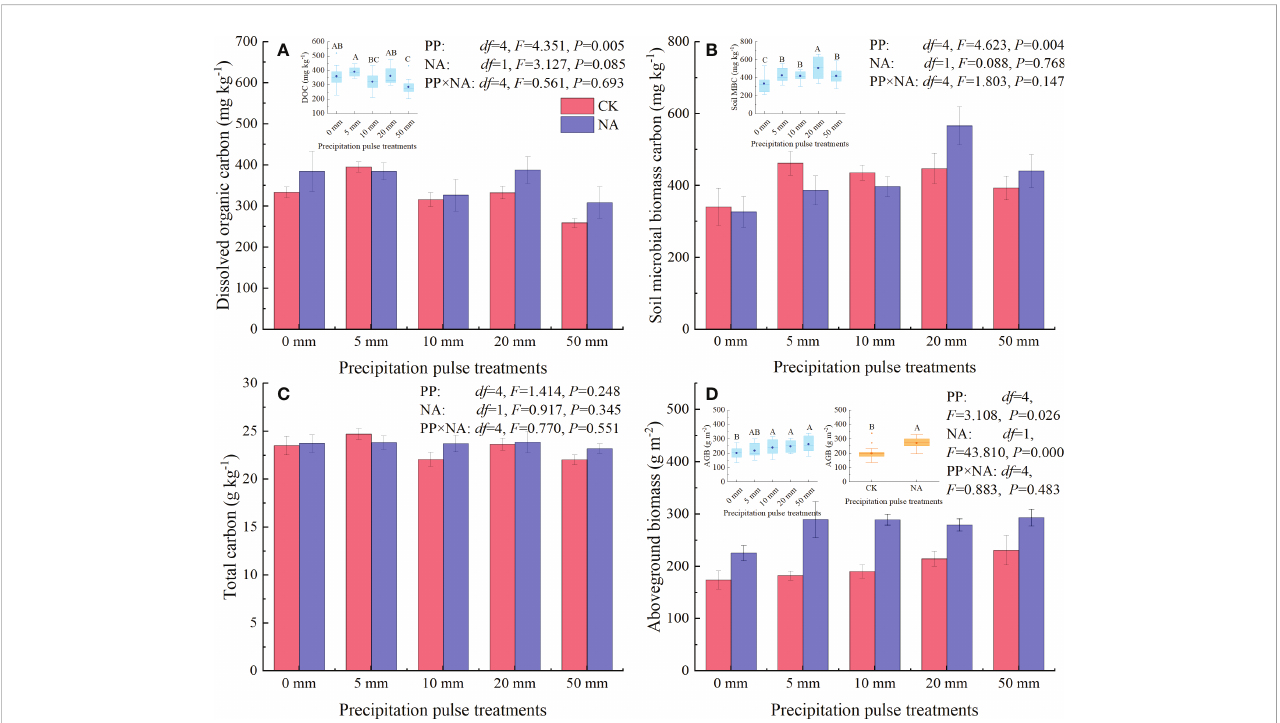
FIGURE 3 Responses of dissolved organic carbon (DOC, A ), soil microbial biomass carbon (MBC, B ), total carbon (TC, C ), and aboveground biomass (AGB, D ) to precipitation pulses and N addition treatments. The inserted graphs (light blue column) in panels A, B, D show the differences in DOC, MBC, and AGB among the precipitation pulses. The inserted graphs (orange column) in panel D show the differences in AGB between the control and N addition treatments. Boxplots show the median (lines within the box) and interquartile range (box boundaries). Whiskers extend to the most extreme data point within 1.5 × (75-25%) data range. The solid point represents the mean value. Different capital letters (above each boxplot) denote signi fi cant differences among the precipitation pulses treatments or between the control and N addition